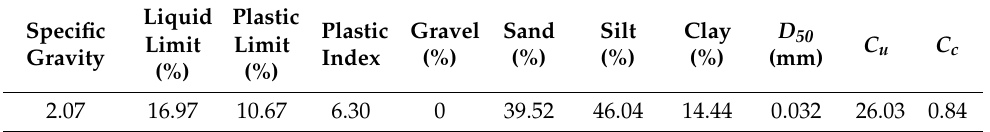
Figure 4. Particle size distribution of the tailings. Table 1. Particle size distribution parameters and main physical properties of the tailings